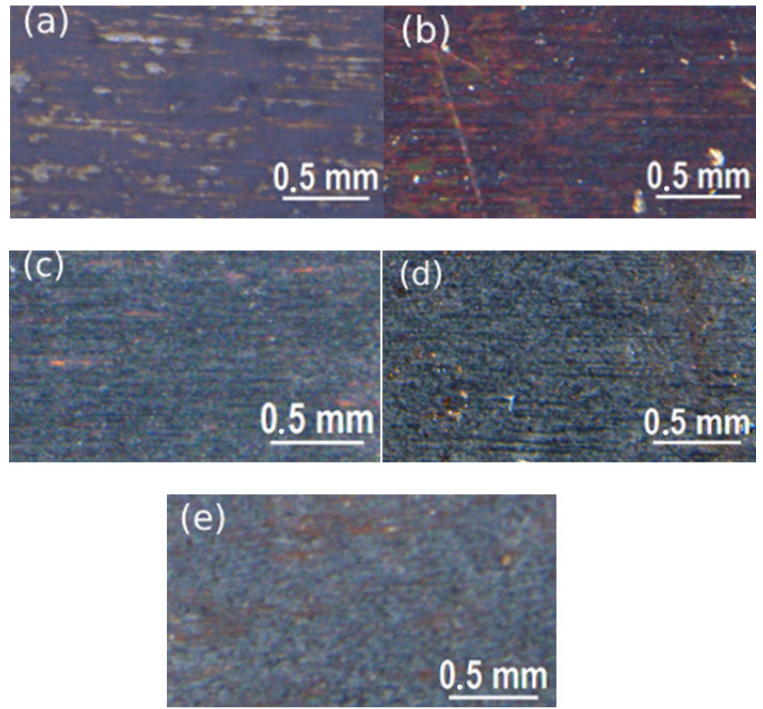
Figure 5. Stereomicroscope images of samples treated with solution 1 at 50 °C with different immersion times: ( a ) 15 min, ( b ) 30 min, ( c ) 50 min, ( d ) 75 min, ( e ) 90 min.